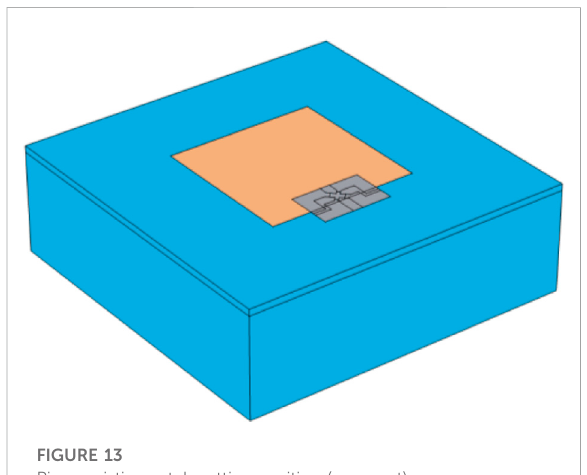
FIGURE 13 Piezoresistive patch setting position (gray